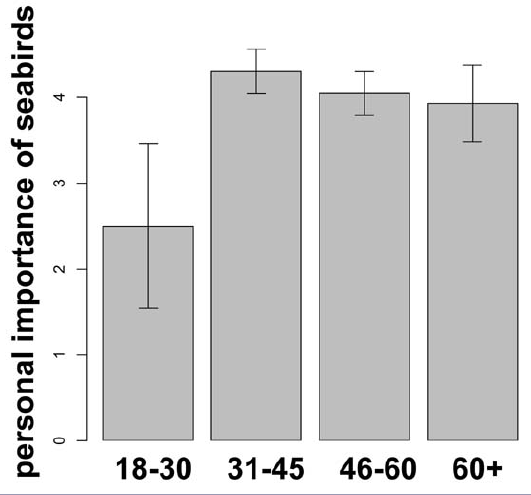
Fig. 2 . Importance of seabirds by age of